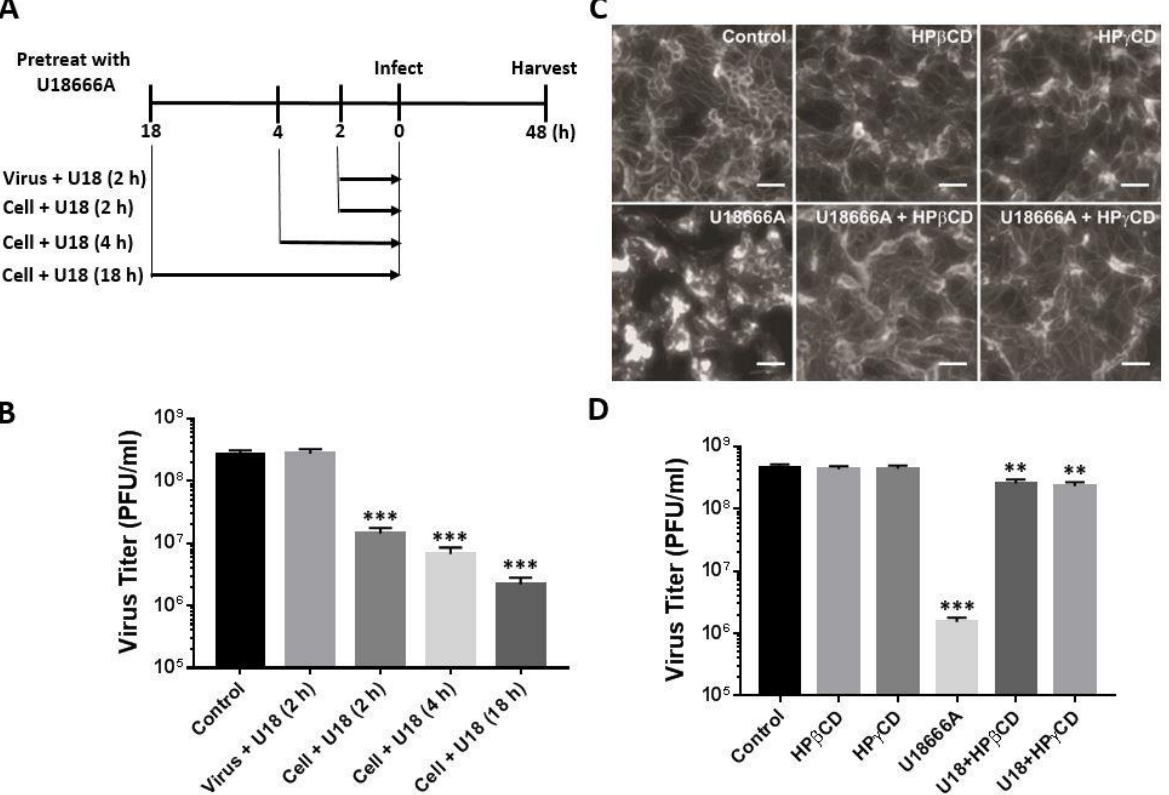
Figure 4. Lysosomal cholesterol homeostasis is critical for PRV infection. ( A ) A schematic diagram for testing the impact of pretreating virus or the target cells with U18666A (5 μg /mL) on PRV infec- tion. ( B ) Infection of PK- 15 cells with PRV (5 MOI) in the presence of U18666A (5 μg /mL) was con- ducted following the scheme outlined in ( A ). Virus titer in the culture supernatant was determined by plaque assay at 48 h post-infection. Treatment with DMSO (0.1%, v / v ) was included as a control. U18: U18666A. Data are mean ± SD ( n = 3). *** p < 0.001. ( C ) PK- 15 cells were treated with HPβCD (1 mM), HPγCD (1 mM), U18666A (5 μg /mL) or U18666A in combination with HPβCD or HPγCD